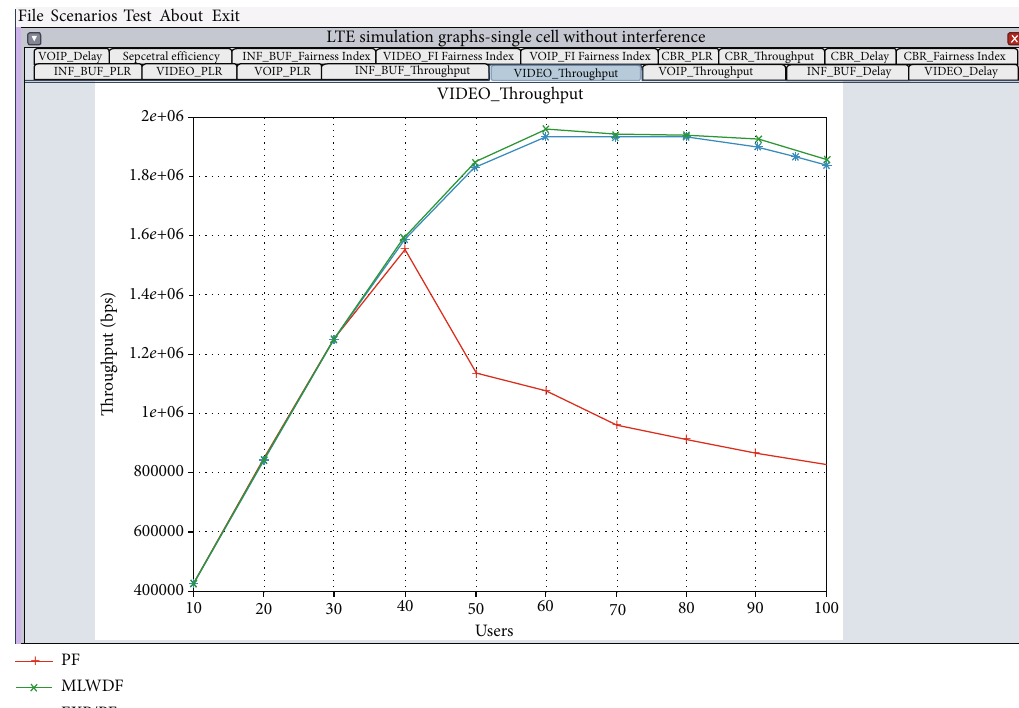
Figure 9: System throughput vs. number of users.